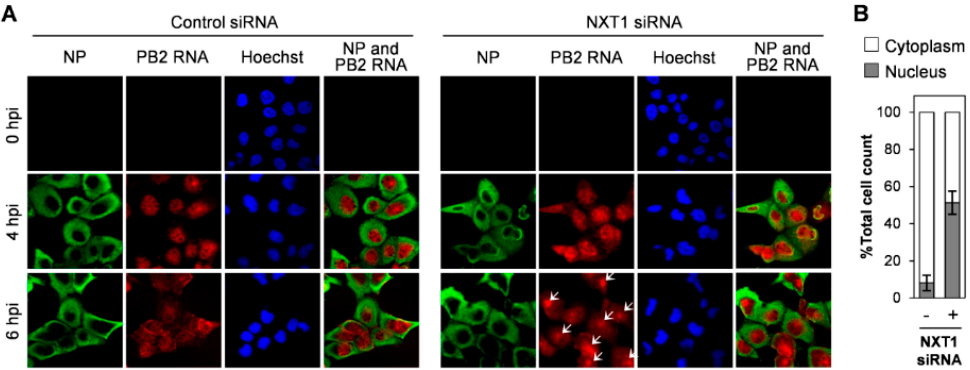
Figure 4. NXT1 knockdown accumulates viral genomic RNA in the nucleus. ( A ) MDCK cells were transfected with control or NXT1 siRNA for 48 h and infected with influenza A/WSN/33 virus at MOI = 10. After 4 and 6 hpi, cells were subjected to fluorescence in situ hybridization (FISH) with a PB2 segment-specific DNA probe conjugated to Quasar 670 for 16 h, followed by immunofluorescence staining with anti-NP and Alexa Fluor 488 goat anti-mouse antibodies. Nuclei were counterstained with Hoechst 33342 and cells were visualized with an Olympus laser scanning confocal fluorescence microscope. White arrows indicate accumulation of PB2 RNA in the nucleus; ( B ) %Total cell count of the cells with nuclear- or cytoplasmic-localization of PB2 RNA from ( A ) at 6 hpi ( n ě 50). Data shown are the results from two independent experiments (error bars) and the mean